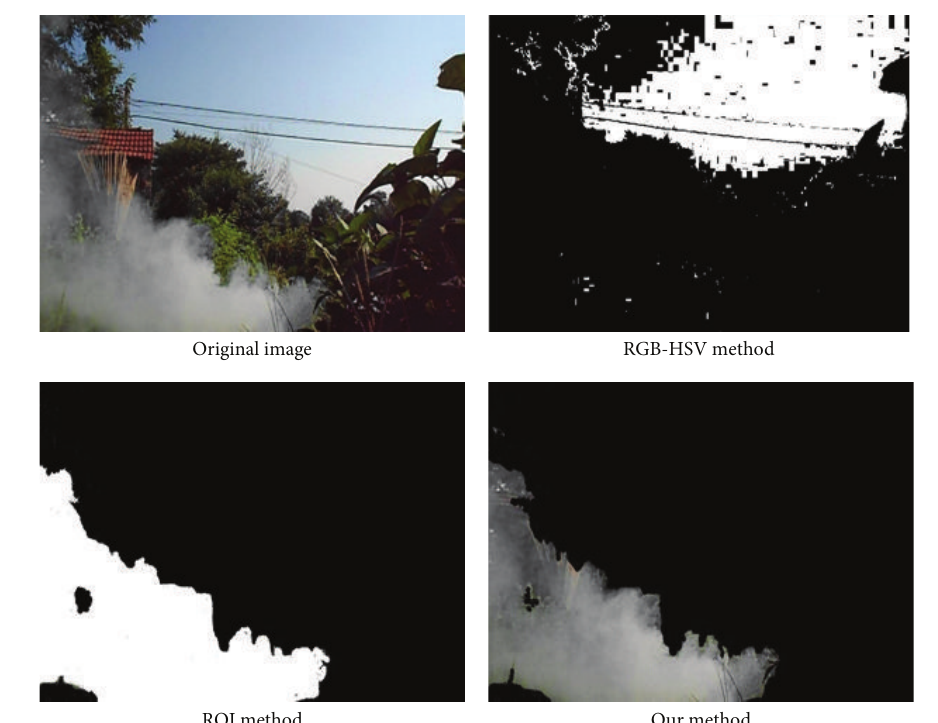
Figure 6: Smoke region extraction of images including interference